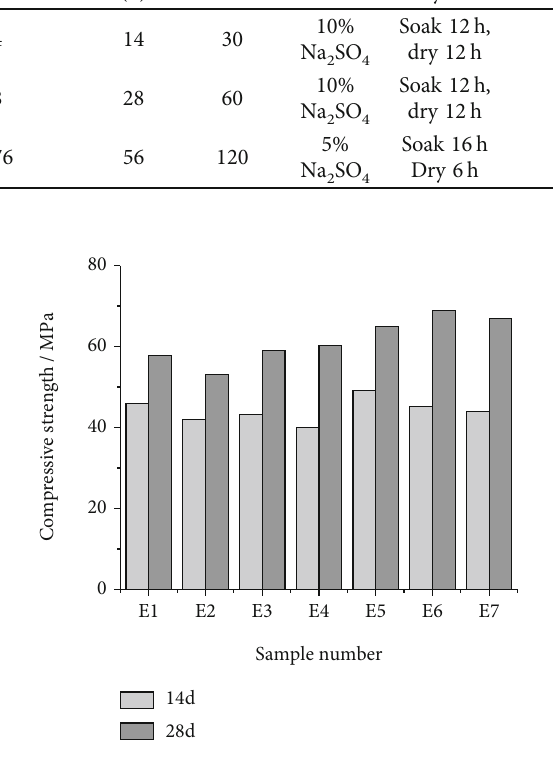
Figure 1: Compressive strength of pile foundation